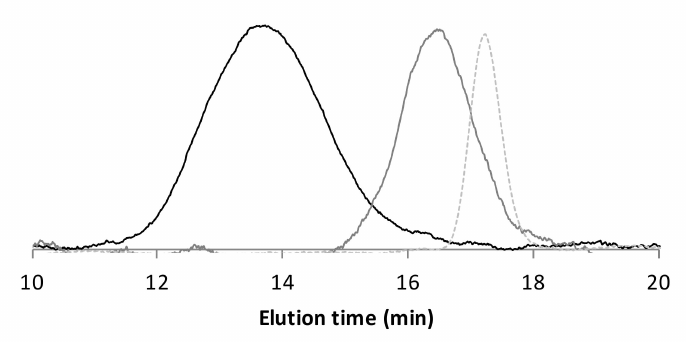
Figure 2. Size exclusion chromatography (SEC) analysis (in N,N-dimethylformamide (DMF)) of the (co)polymers along synthesis process. From right to left: poly(ethylene glycol) methacrylate (PEGMA) (grey dotted line): M n (SEC) = 3900 g · mol − 1 , Đ = 1.06; PLA-SG1 (grey line): M n (SEC) = 5700 g · mol − 1 , Đ = 1.36; PLA-b-P(NIPAAm-PEGMA) (black line): M n (SEC) = 46,000 g · mol − 1 , Đ =